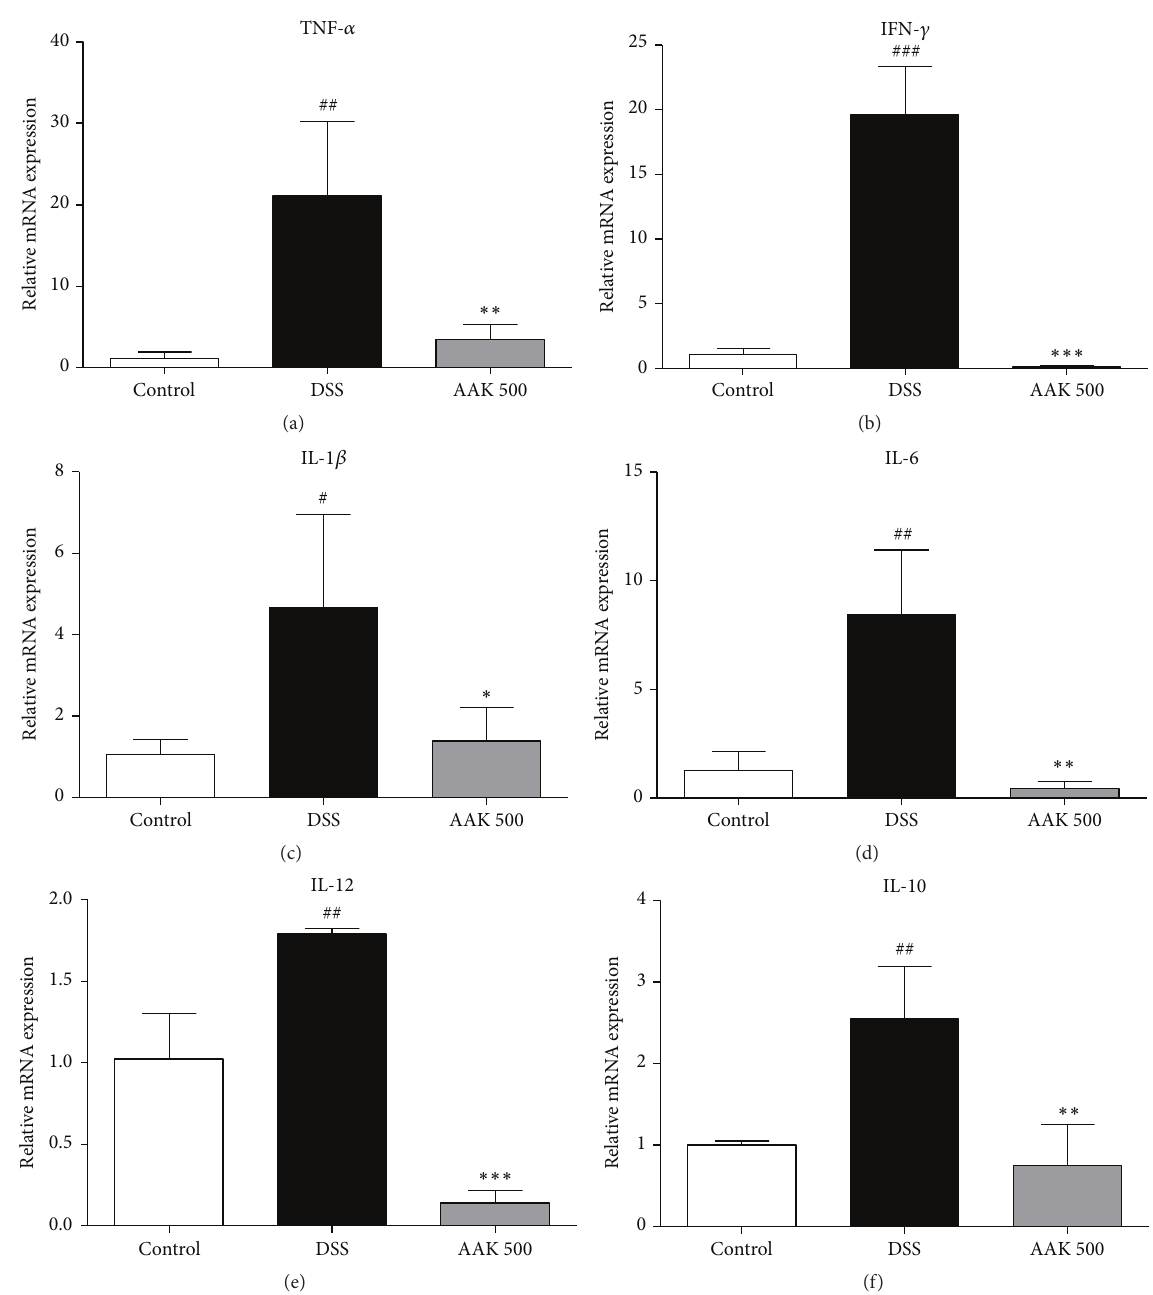
Figure 5: Effects of AAK extract on the gene expression levels of inflammatory mediators in DSS-induced colitis. (a–f) mRNA expression of TNF- 𝛼 , IFN- 𝛾 , IL-1 𝛽 , IL-6, IL-12, and IL-10 was measured by real-time PCR, and GAPDH was used as an endogenous control. Fold-changes are expressed as the mean ± SD ( 𝑛 = 4 – 6 per group). # 𝑝 < 0.05 , ## 𝑝 < 0.01 , and ### 𝑝 < 0.001 versus control; ∗ 𝑝 < 0.05 , ∗∗ 𝑝 < 0.01 , and ∗∗∗ 𝑝 < 0.001 versus